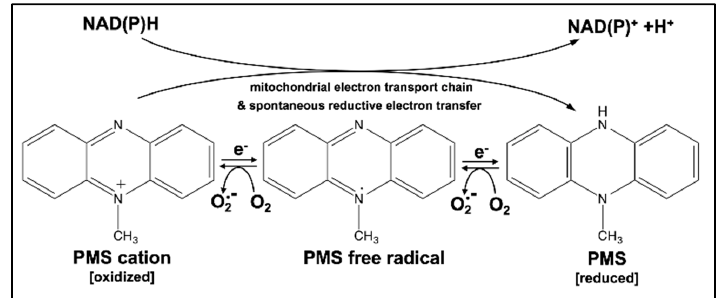
Figure 1. Redox reactivity of Phenazine Methosulfate (PMS). Reductively (NADPH)-driven PMS redox cycling involving single- or two-electron transfer reactions can cause reactive oxygen species (ROS) production with formation of superoxide radical anions. The three redox states of PMS are